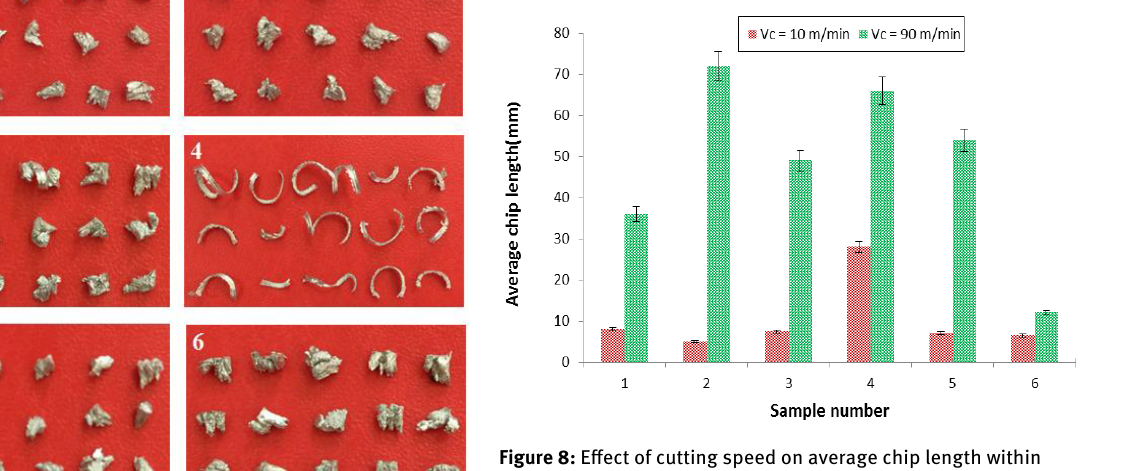
Figure 7: Chip formation style shape for all samples during cutting speed of 90 m/min.